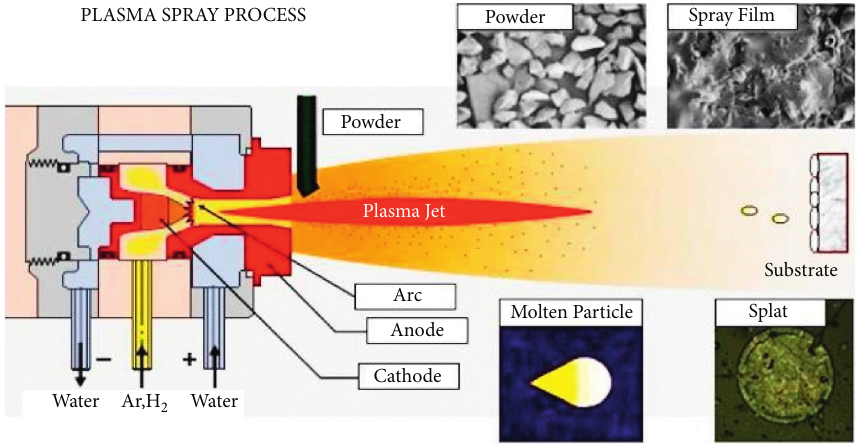
Figure 1: Schematic diagram of plasma spraying technique